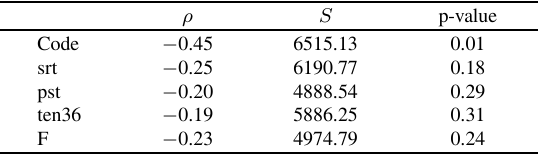
Table 5 Correlations of neuropsychological variables (pst: paced auditory serial addition test, F: fl uency test, code: code subtest, ten36: 10/36 visuo-spatial learning test and srt: selective reminding test) with EDSS. Correlation is quanti fi ed using Spearman’s ρ and tested rank statistics ( S )